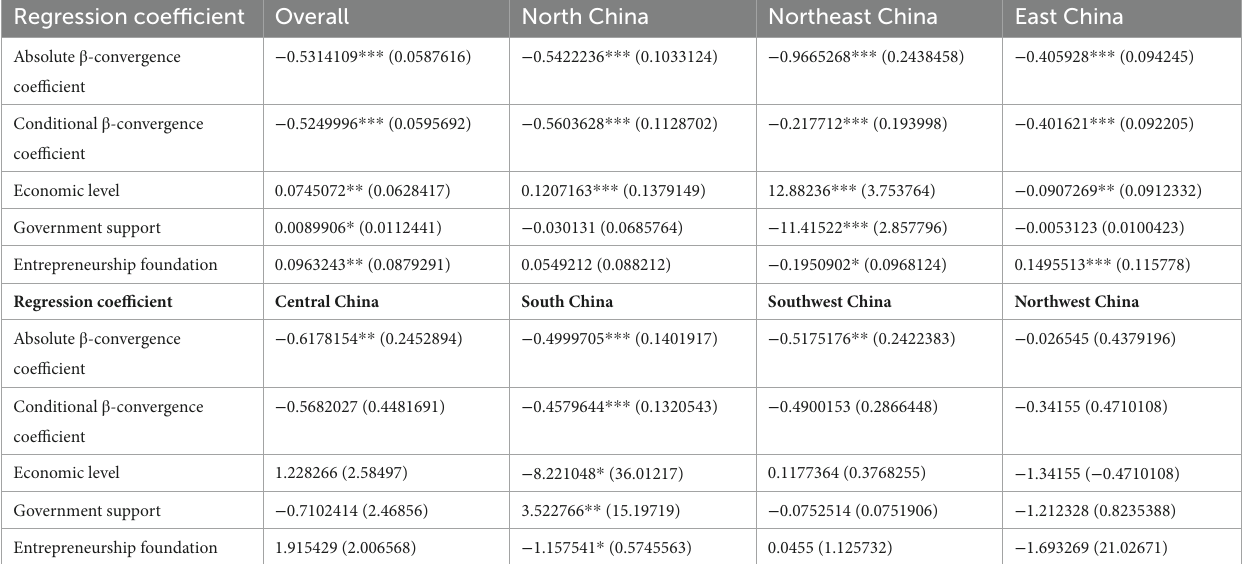
TABLE 6 Test results for absolute convergence and conditional convergence of β . Regression coefficient